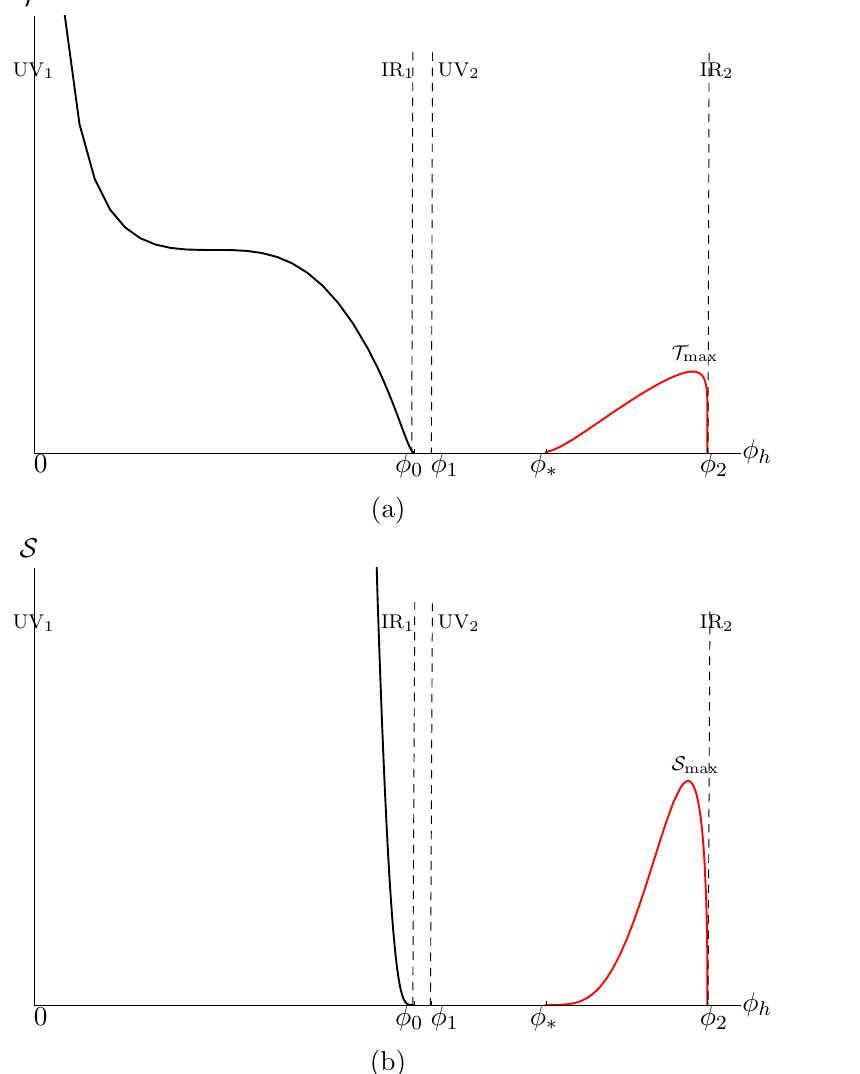
Figure 8 . The dimensionless temperature (a) and the entropy density (b) as a function of the scalar (cid:12)eld horizon value (cid:30) h for black holes connecting to UV 1 . observe, there is a range of horizon values, (cid:30) denote by (cid:30) ) for which no solution exists which continuously connects to UV (cid:3)